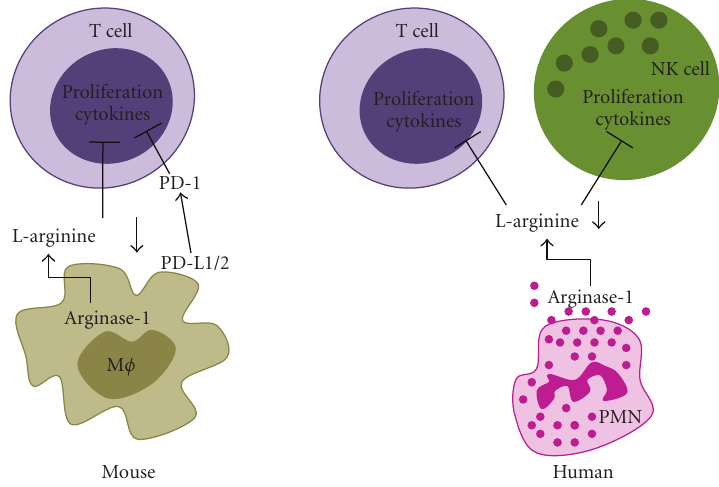
Figure 2: Role of arginase in immunosuppression. During parasitic infections, mouse macrophage-specific arginase-1 induces T cell suppression due to arginase-mediated depletion of L-arginine in the T cell environment, which leads to CD3 ζ chain down-regulation. Additionally, PD-1/PD-L pathway may be also involved in the T cell suppression. Furthermore, human granulocyte arginase can also induce immunosuppression by a similar mechanism. Upon human polymorphonuclear granulocytes (PMN) cell death, arginase is liberated and high activities of this enzyme accumulate extracellularly during purulent inflammatory reactions. PMN arginase induces a profound suppression of T cell and NK cell proliferation and cytokine